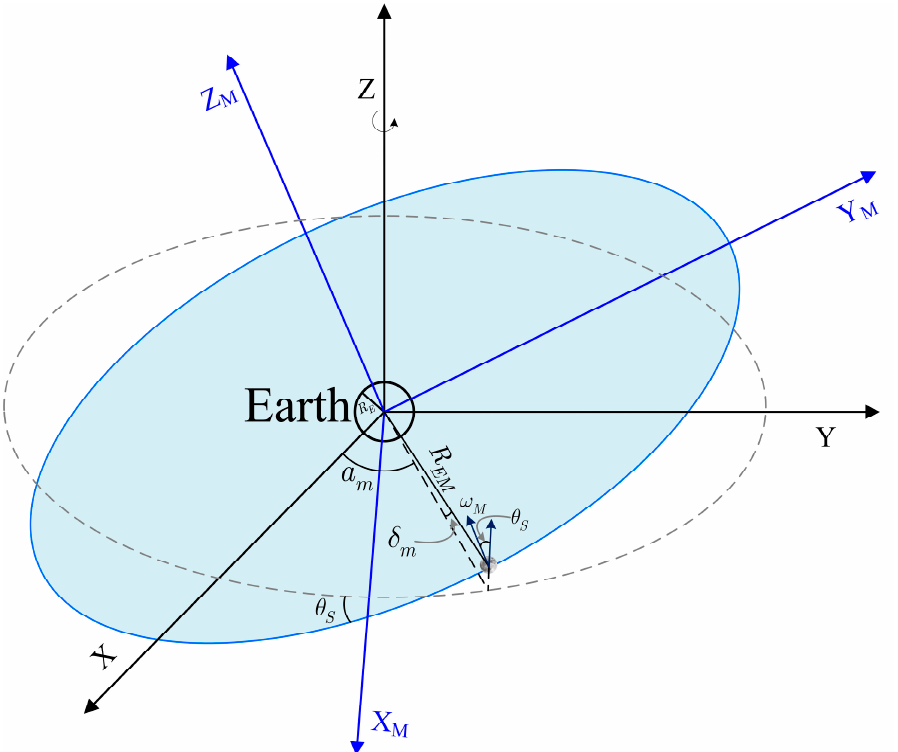
Figure 5. Imaging geometry of Moon-Based SAR in consideration of lunar revolution.